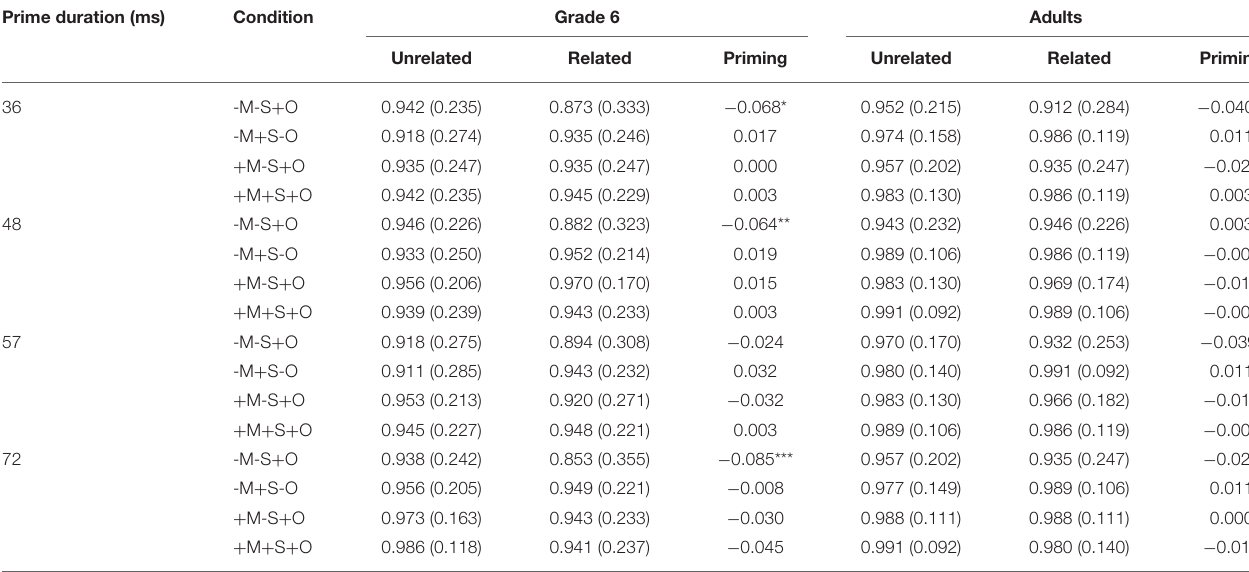
TABLE 4 | Mean accuracy rates and standard deviation of Grade 6 children and adults across the four